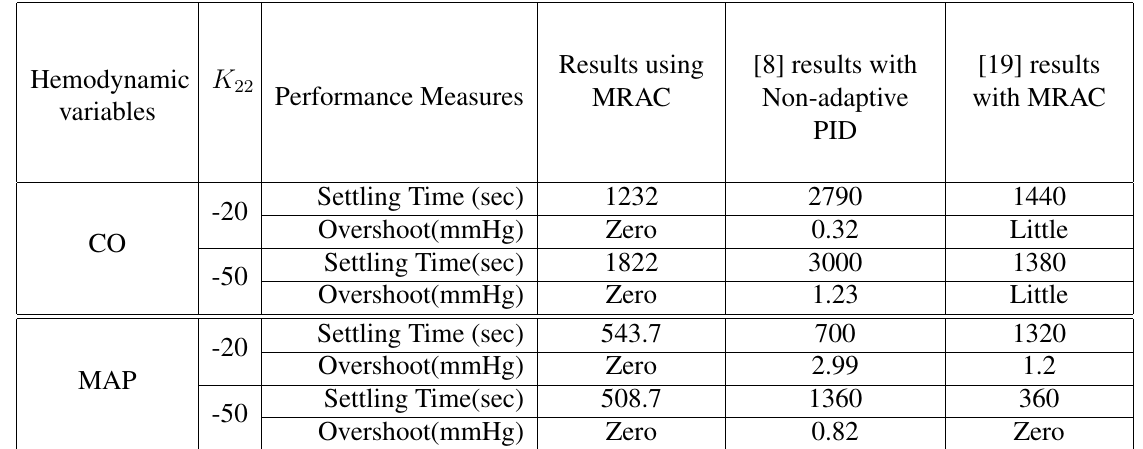
Table 2: Simulation results of multi-drug infusion control using MRAC